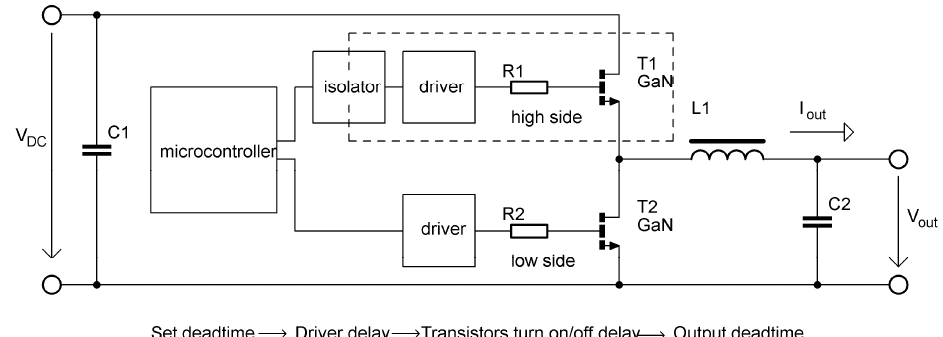
Figure 1. A typical gallium nitride (GaN)-based half-bridge configuration.